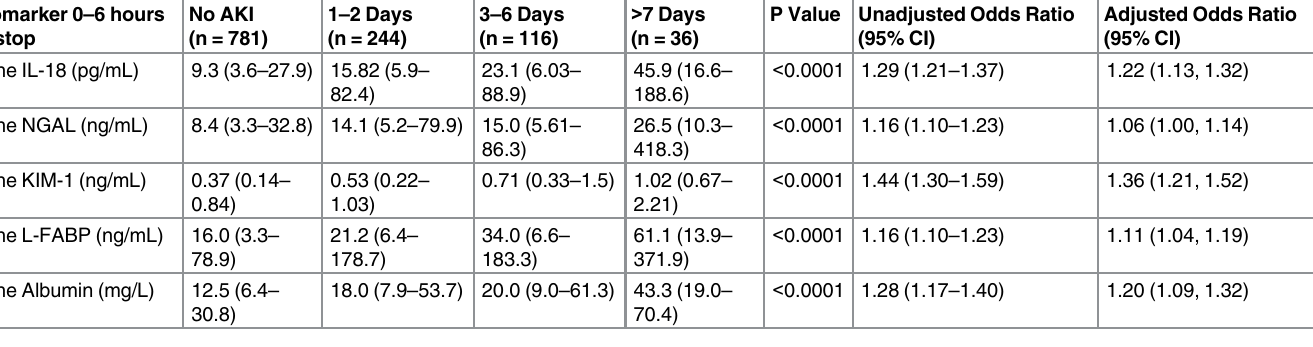
Table 2. Median Values of Biomarkers by Duration of AKI and Odds Ratios per Log Increase in Biomarker for Increased Duration Category. Biomarker 0 – 6 hours